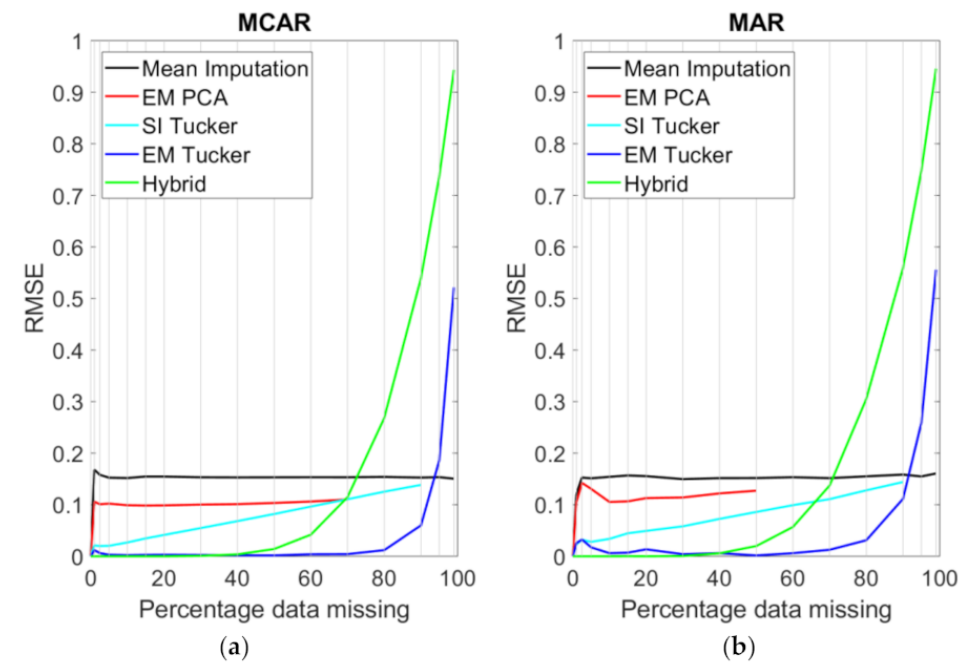
Figure 8. RRMSE for different models using the homogeneous tensor, SIM1, with artificially added MCAR ( a ) and MAR ( b ) elements. RRMSE values were calculated at positions indicated by the light grey vertical lines.